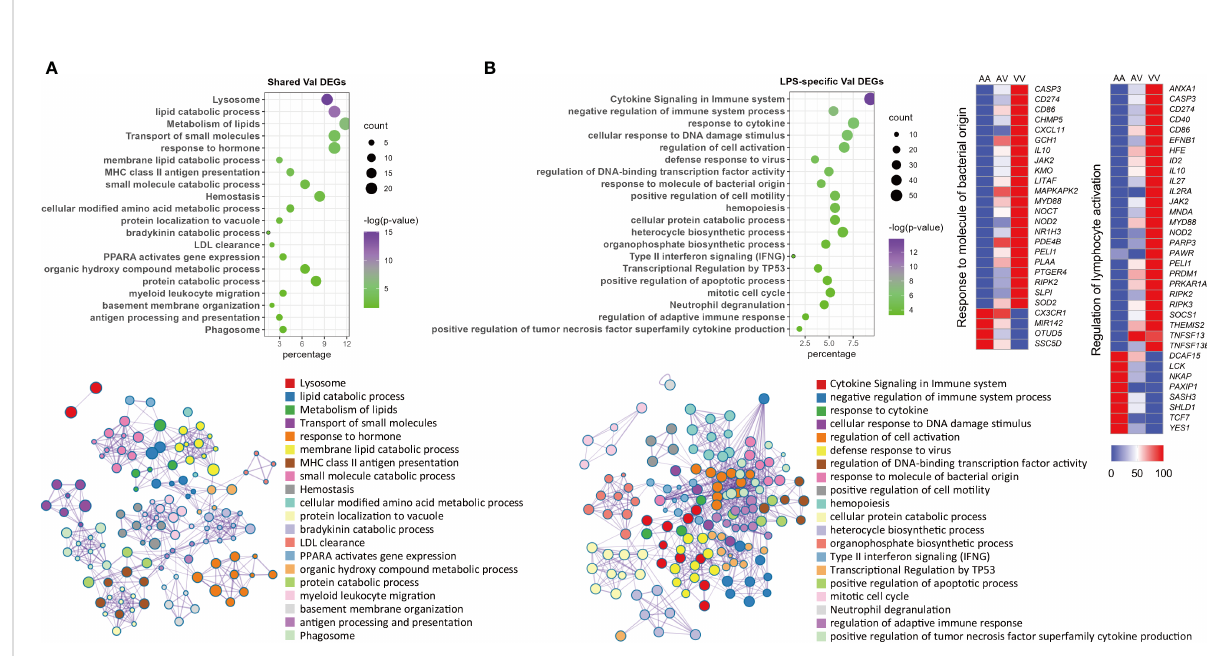
FIGURE 4 Enrichment analysis of shared and LPS-speci fi c Val-regulated DEGs. (A) Functional terms enriched for Val-regulated DEGs common in all the four groups. (B) Functional terms enriched for LPS-speci fi c Val-regulated DEGs with relative gene expression pro fi les for two representative LPS-speci fi c terms. Enrichment analysis was performed using the Metascape. Bubble plots illustrate signi fi cance and gene counts of top enriched terms, where purple indicates higher signi fi cance and green indicates lower signi fi cance and bubble size is positively correlated with gene counts. Networks illustrate the relationship between terms, where each node represents one functional term and terms with Kappa similarities above 0.3 are connected by edges. Each term cluster is labeled and represented by its most signi fi cant member and all members in the same term cluster are indicated by the same